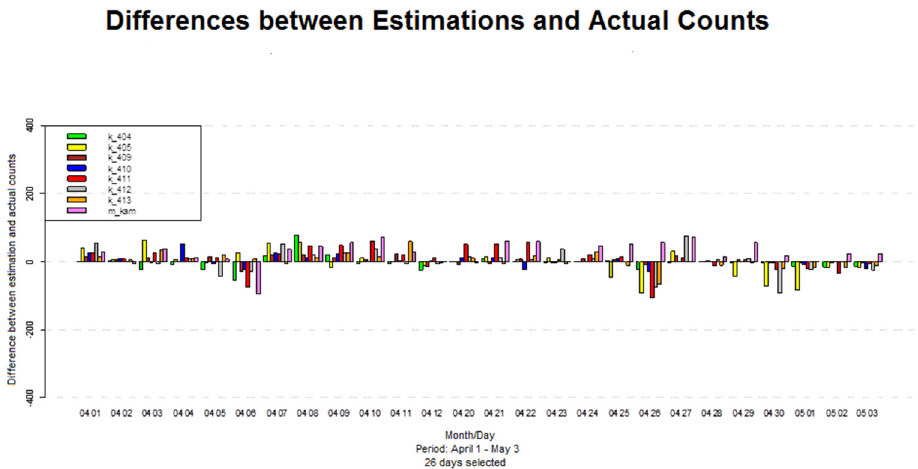
Figure 13. Differences between estimated passing individuals and photo content assessment in both monitored forests in Freising, Bavaria, Germany. For color codes and locations of the camera traps, see Figures 1 and 2 and Appendix A, Table A1, Note: Different time frame for camera #410 (color code blue) only until March 2016